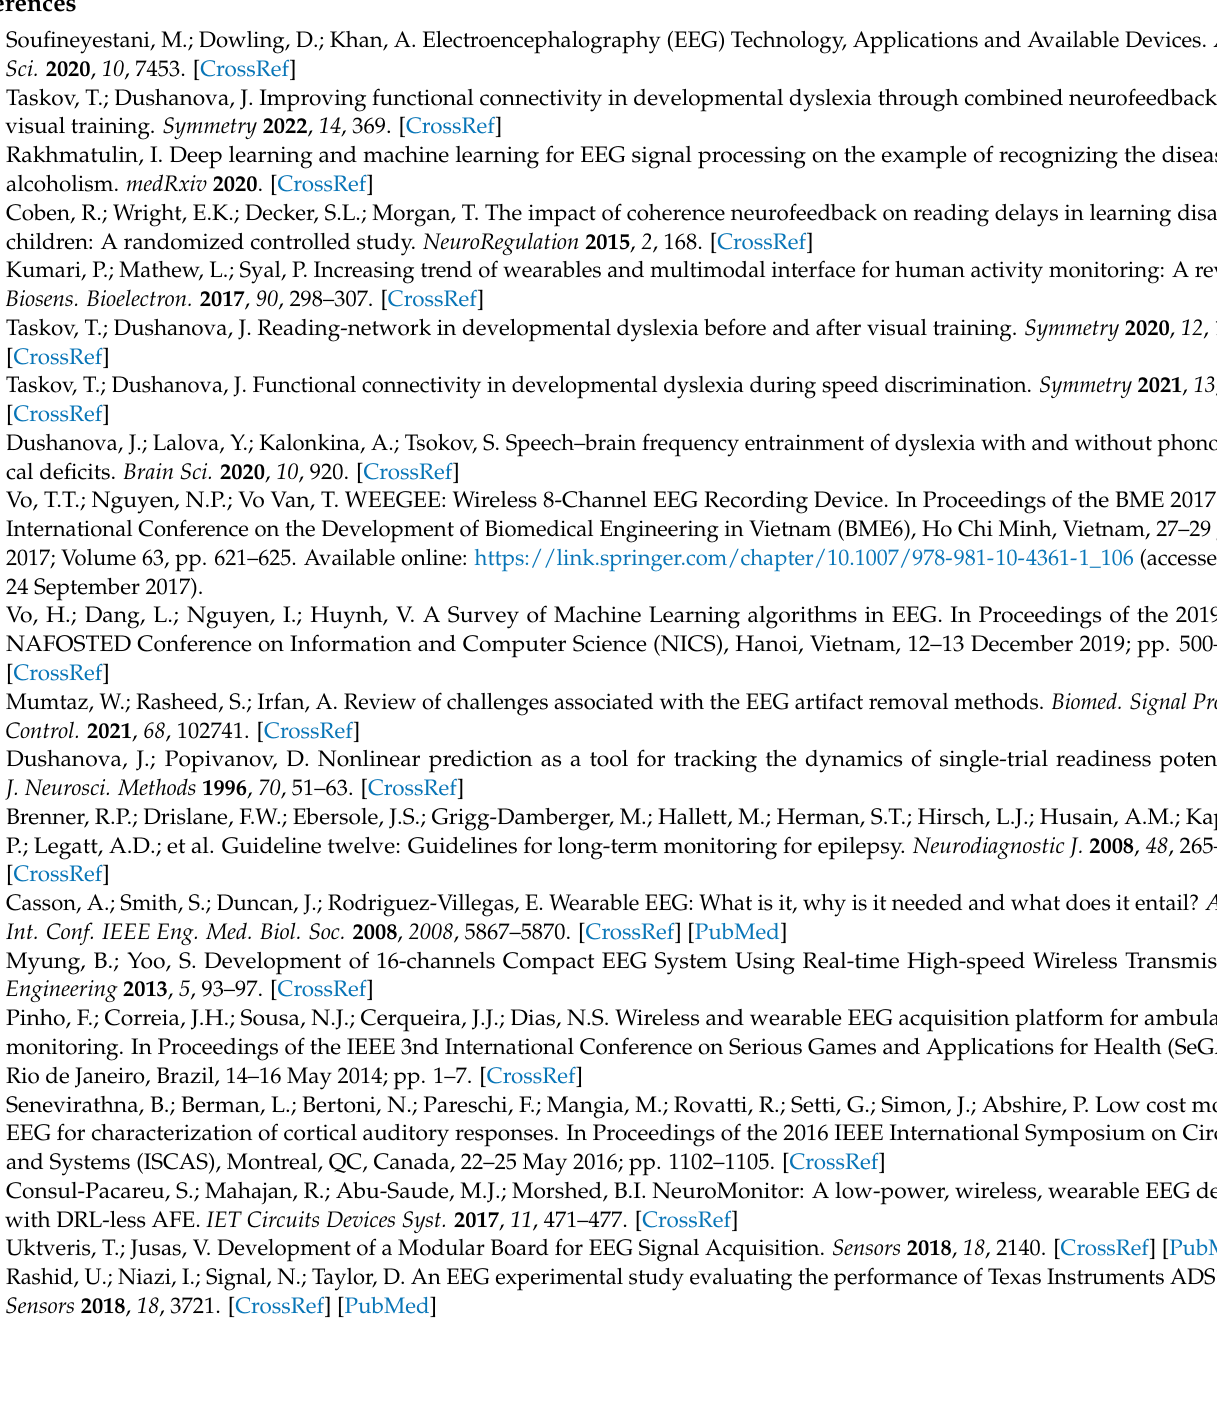
Figure A3. Device assembly: ( A ) image of the device, ( B ) 40-sensor headset according to International 10-20 (blue) and 10-10 systems (yellow circles), ( C ) experimental paradigm, and ( D ) experimental set-up.